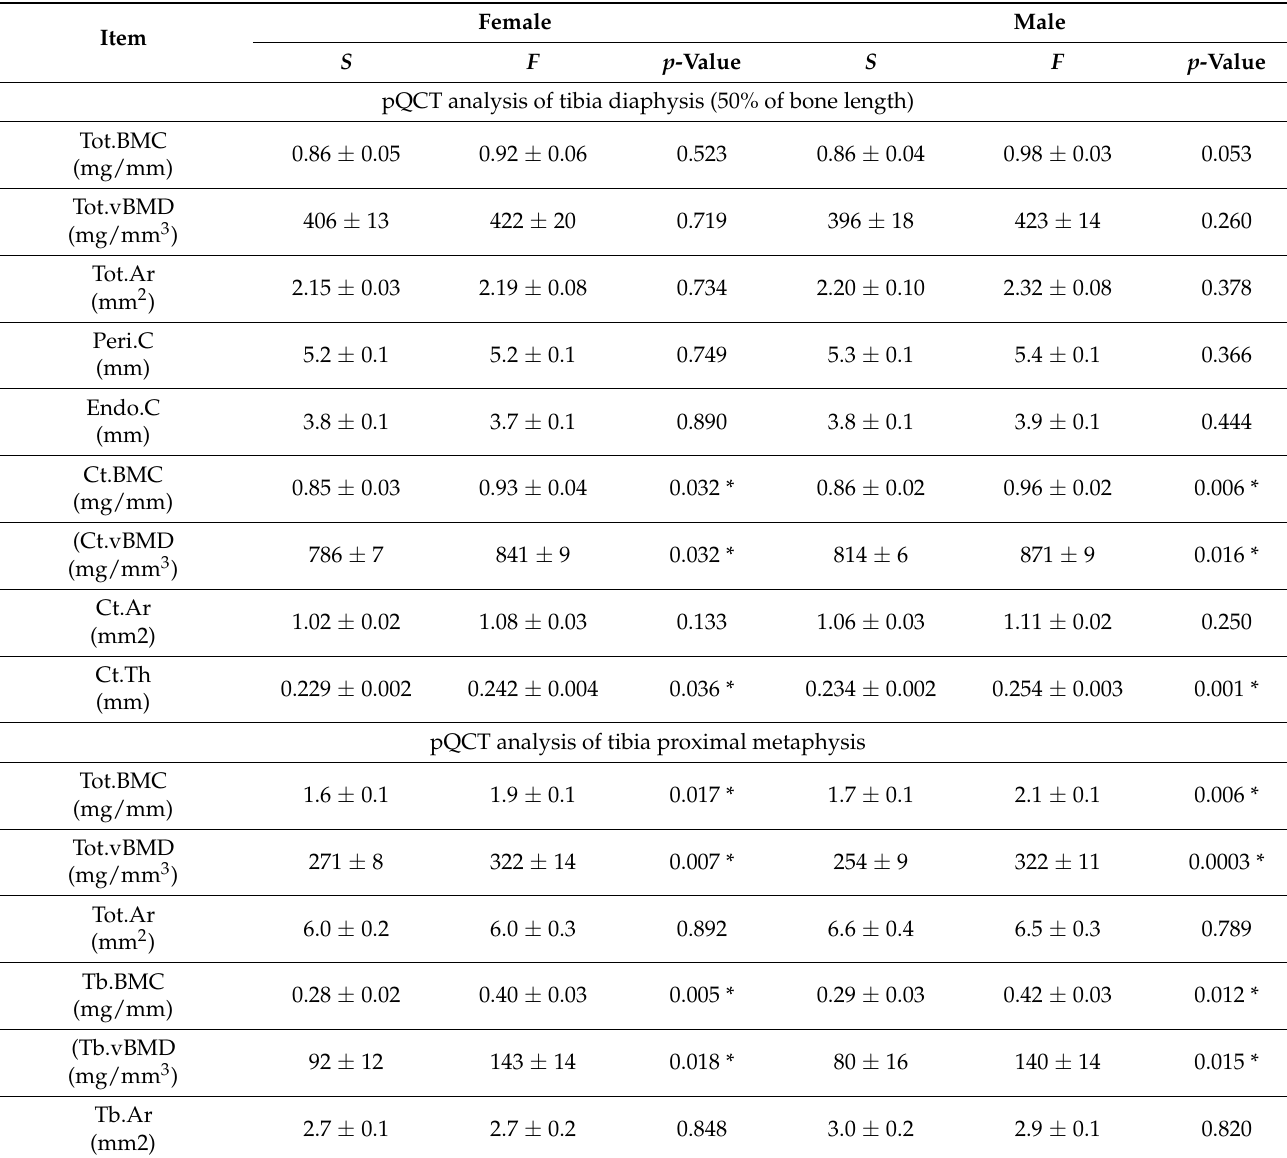
Table 3. The tomographic (pQCT) parameters of the total cross-section of the diaphysis and the proximal metaphysis as well as cortical and trabecular bone tissue of the tibia of female and male rats on the weaning day. Female Male Item S F p -Value S F p -Value pQCT analysis of tibia diaphysis (50% of bone